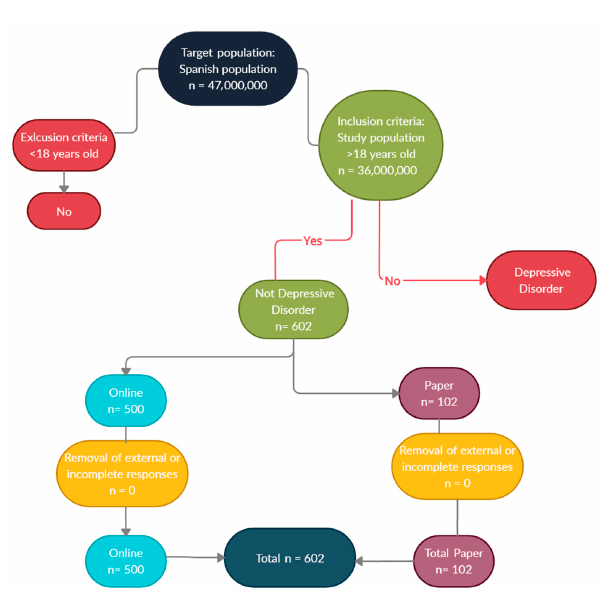
Figure A1. Flow diagram of the sample recruitment process.